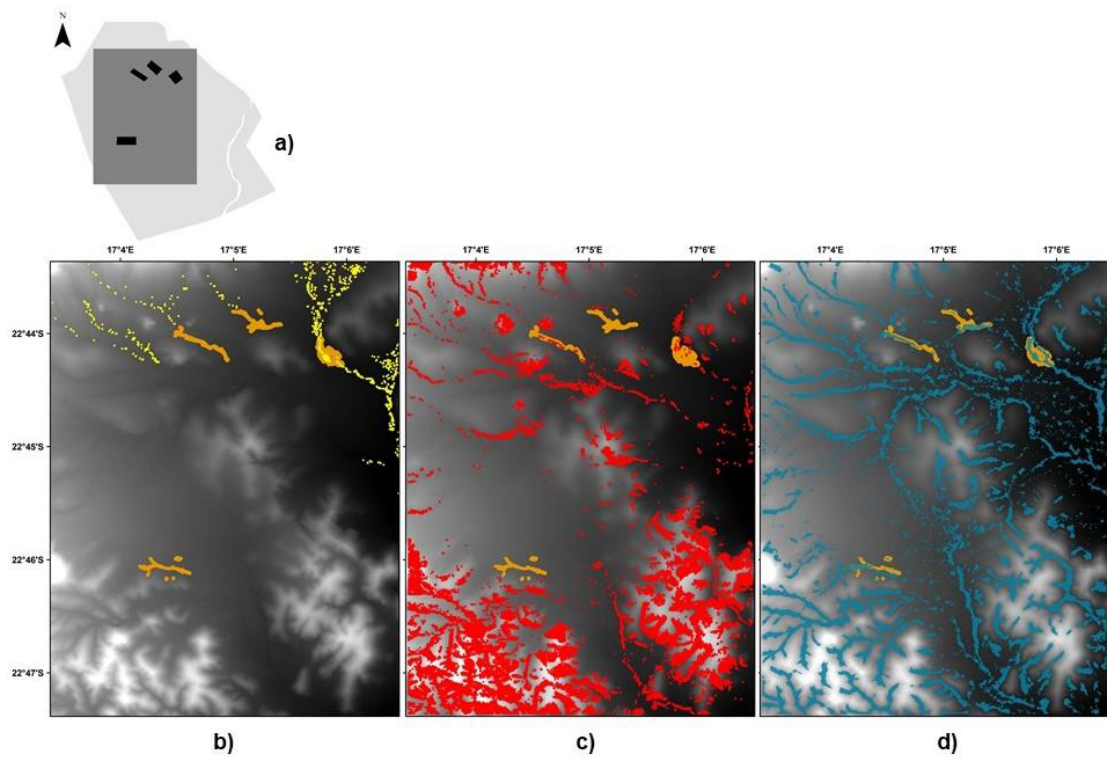
Figure 8. ( a ) Location of the rectangular Area of Interest (AOI) within Krumhuk Farm and spatial distribution of the VPs. ( b ) Gully detection results using IMR with positive results represented in yellow. ( c ) Gully detection results using SMPF with positive results represented in red. ( d ) Gully detection results using MPCA with positive results represented in blue. Pale yellow polygons present in the three images ( b – d ) represent gully areas.